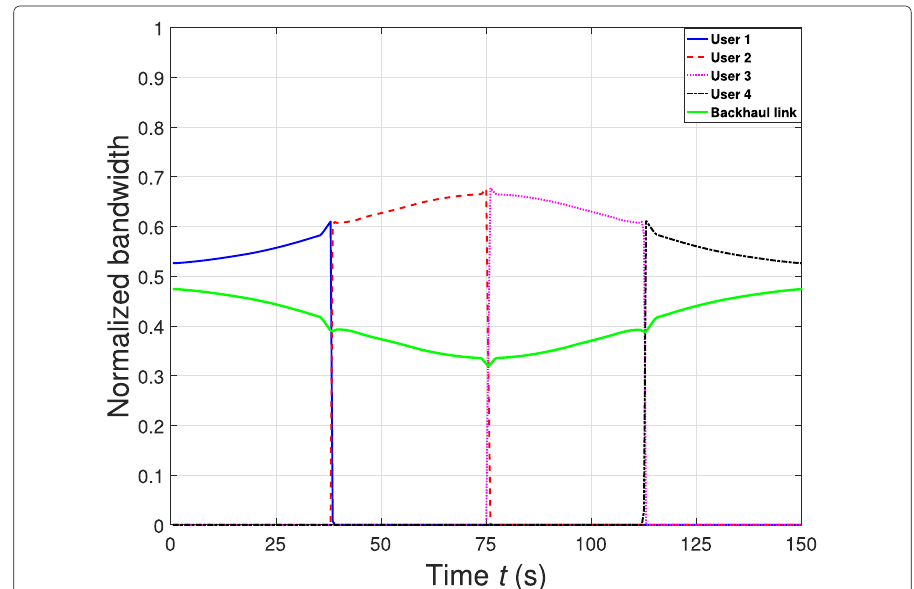
Fig. 4 Normalized bandwidth of the users and the backhaul optimized by the proposed “B-P-T-OPT” schemes versus time t when T = 150 s